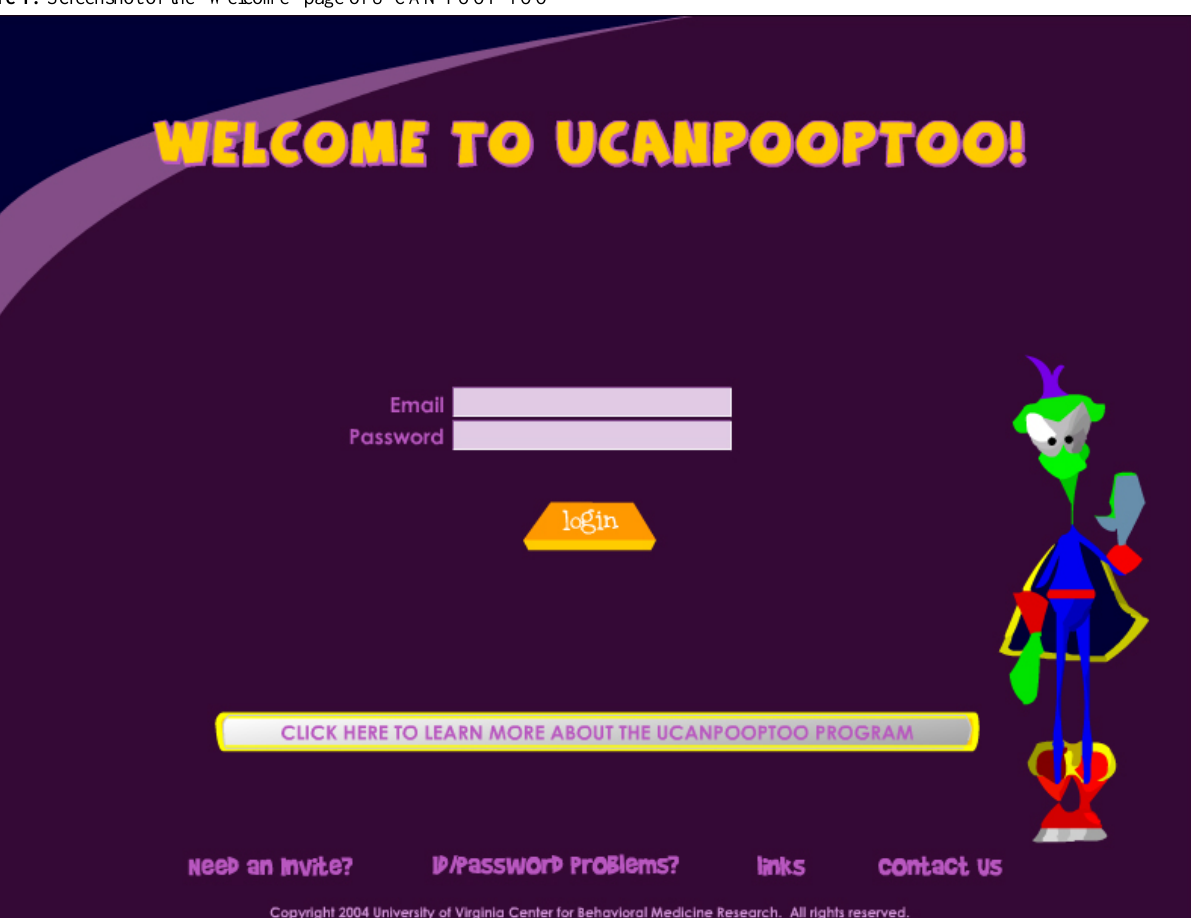
Figure 1. Screenshot of the “Welcome” page of